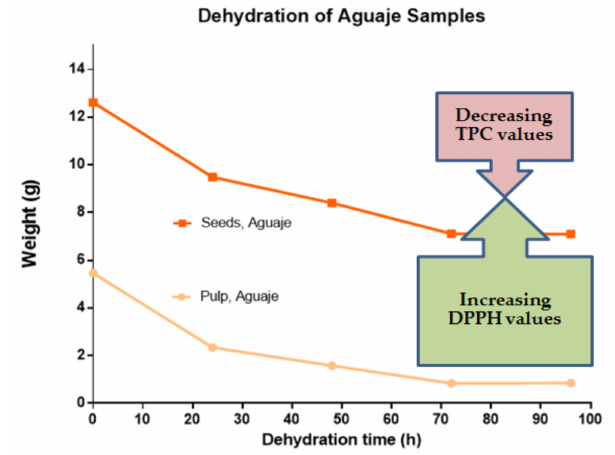
Figure 5. TPC (mg of gallic acid equivalents) and DPPH (mg ascorbic acid equivalents) in M. flexuosa (aguaje) pulp and seeds with respect to a constant dehydration pattern from 0 to 96 h. The stable flattening dehydration pattern is connected to lower TPC values and higher redox activity. From 72 to 96 h, the weight differences were stable, and statistical significance was registered at different points in the dehydration